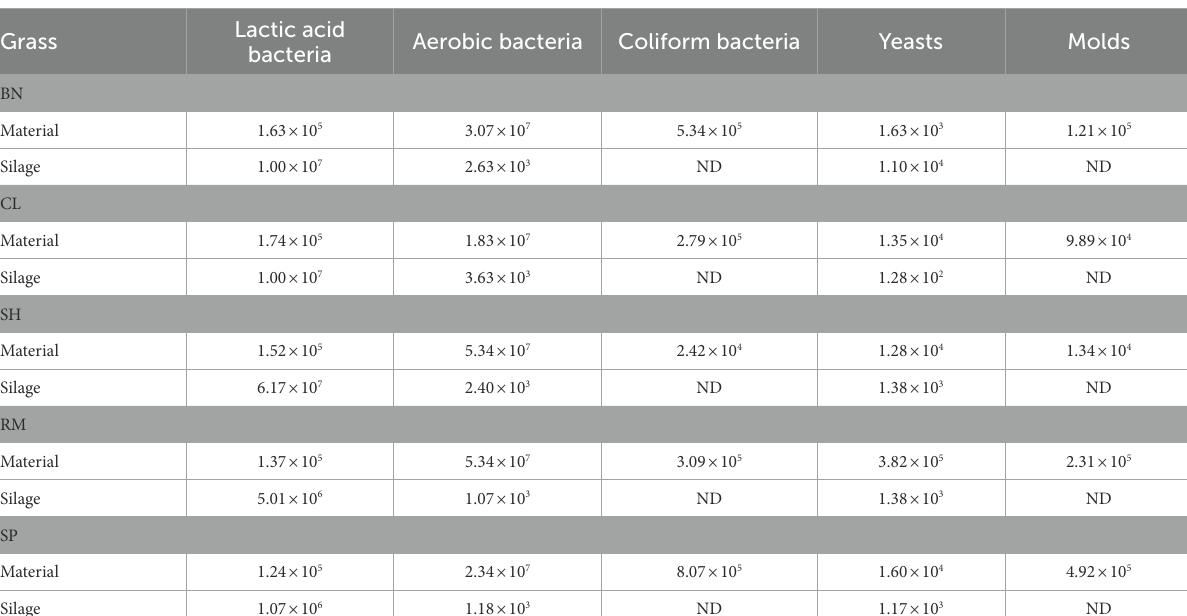
TABLE 1 Microbial population (cfu/g FM) of native grasses.